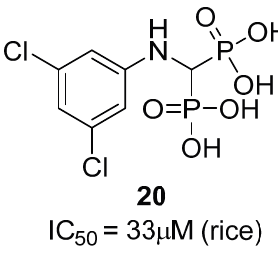
Figure 6. Structure of the most active aminomethylenebisphosphonic acid derivative .